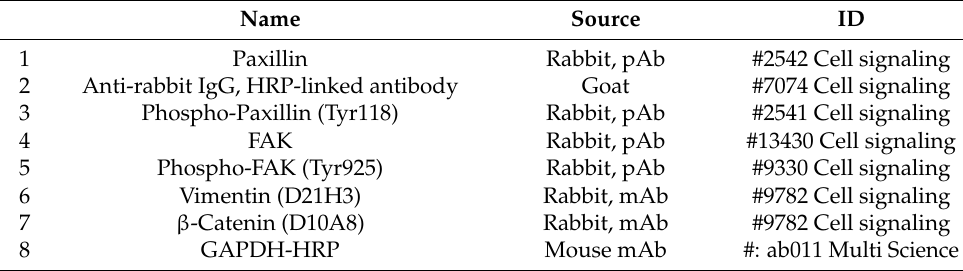
Table 1. List of antibodies used in the